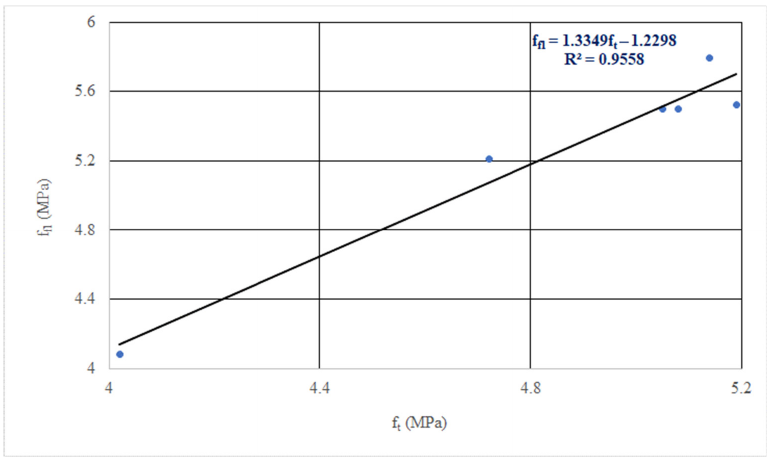
Figure 7. Correlation between split tensile strength, f t , and flexural strength, f fl .